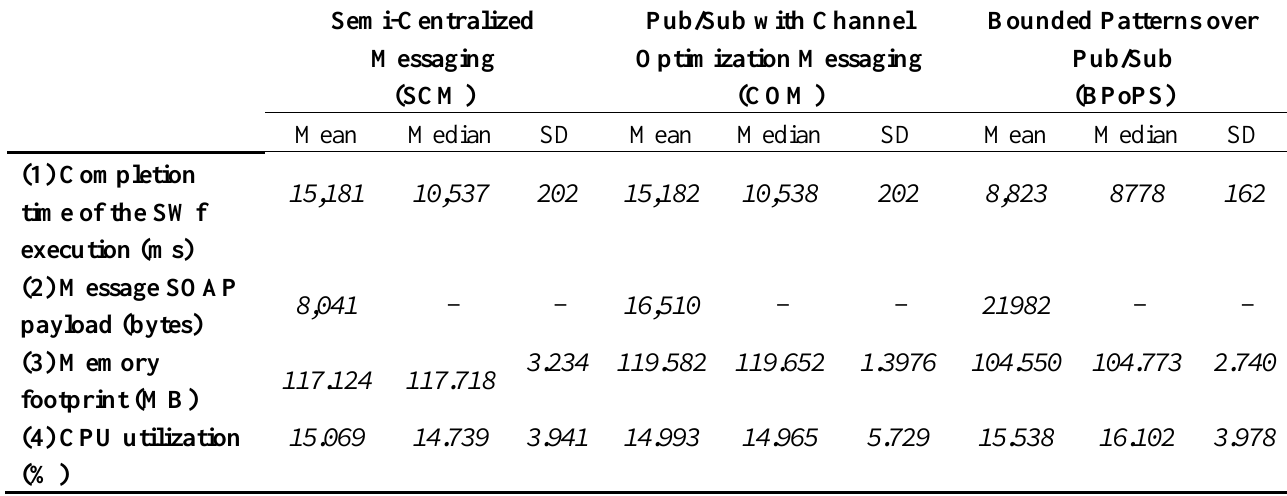
Table 2. Quantitative evaluation of the evaluation